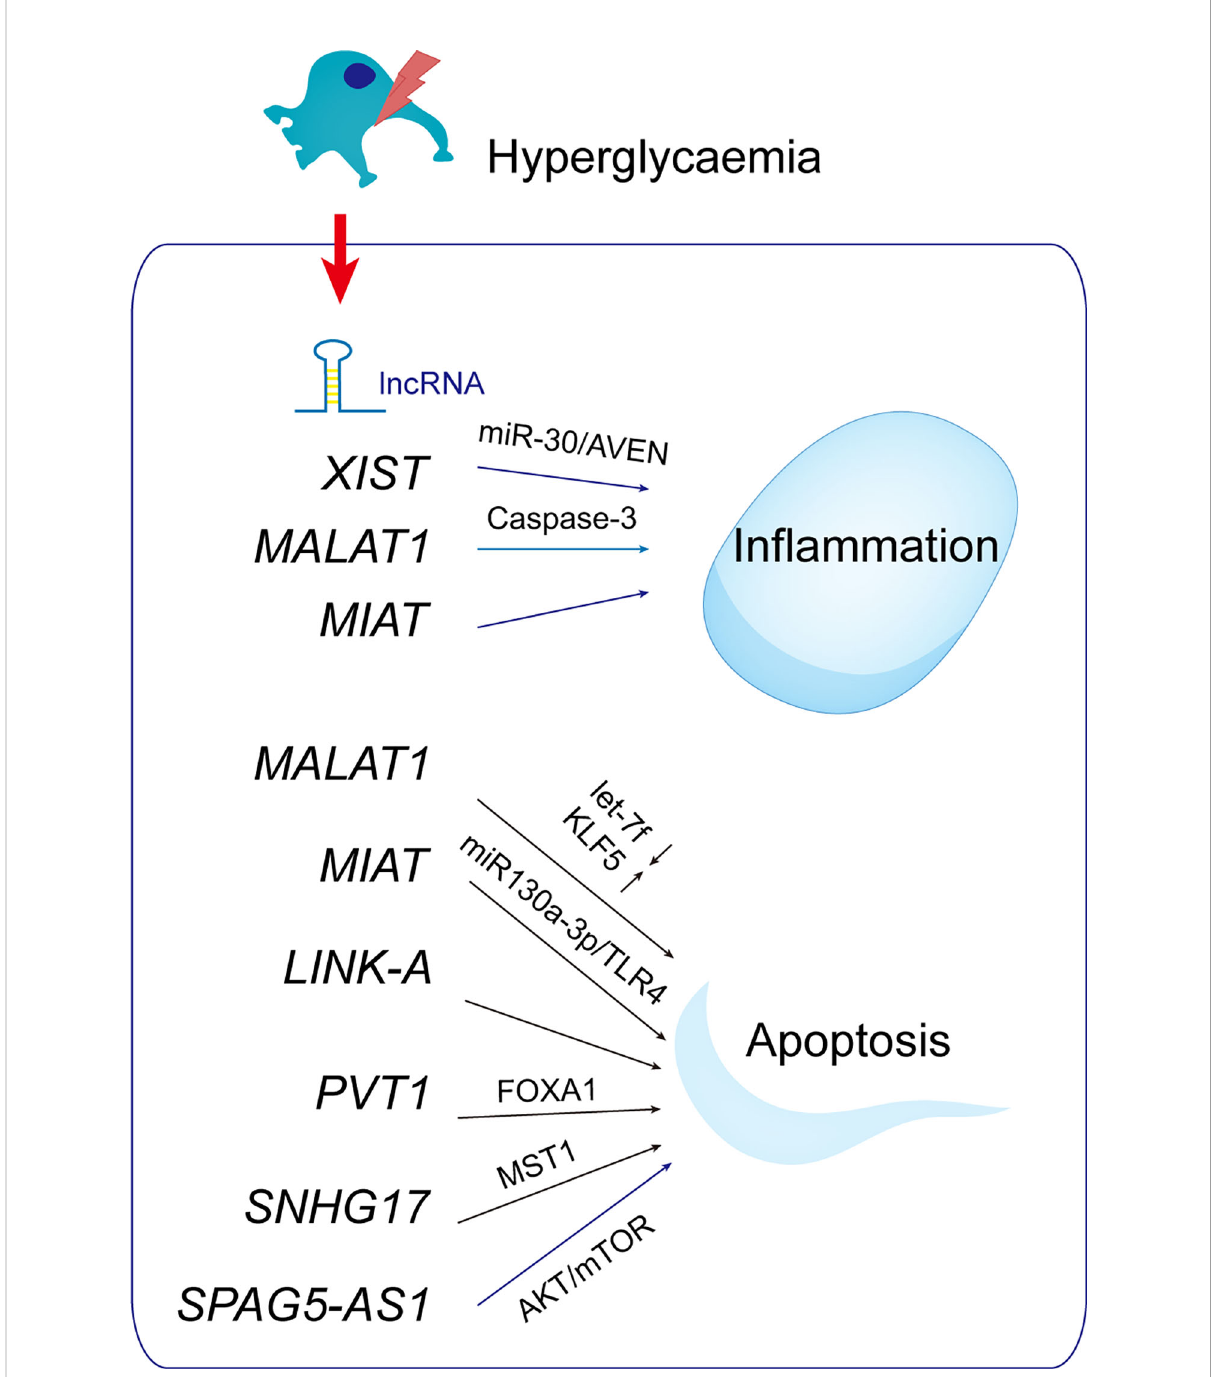
FIGURE 8 LncRNAs with potential roles in podocytopathies. Hyperglycemia up- or down-regulates lncRNAs in podocytes, resulting in